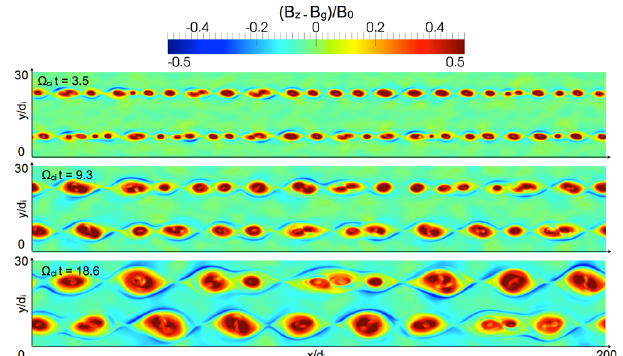
Fig. 3. Contour plots of the out-of-plane magnetic field without the guide field, B z − B g , normalized to B 0 at different times. Each magnetic island is characterized by an out-of-plane core magnetic field, whose value is approximately equal to the guide field B g = 0 . 5 B 0 .